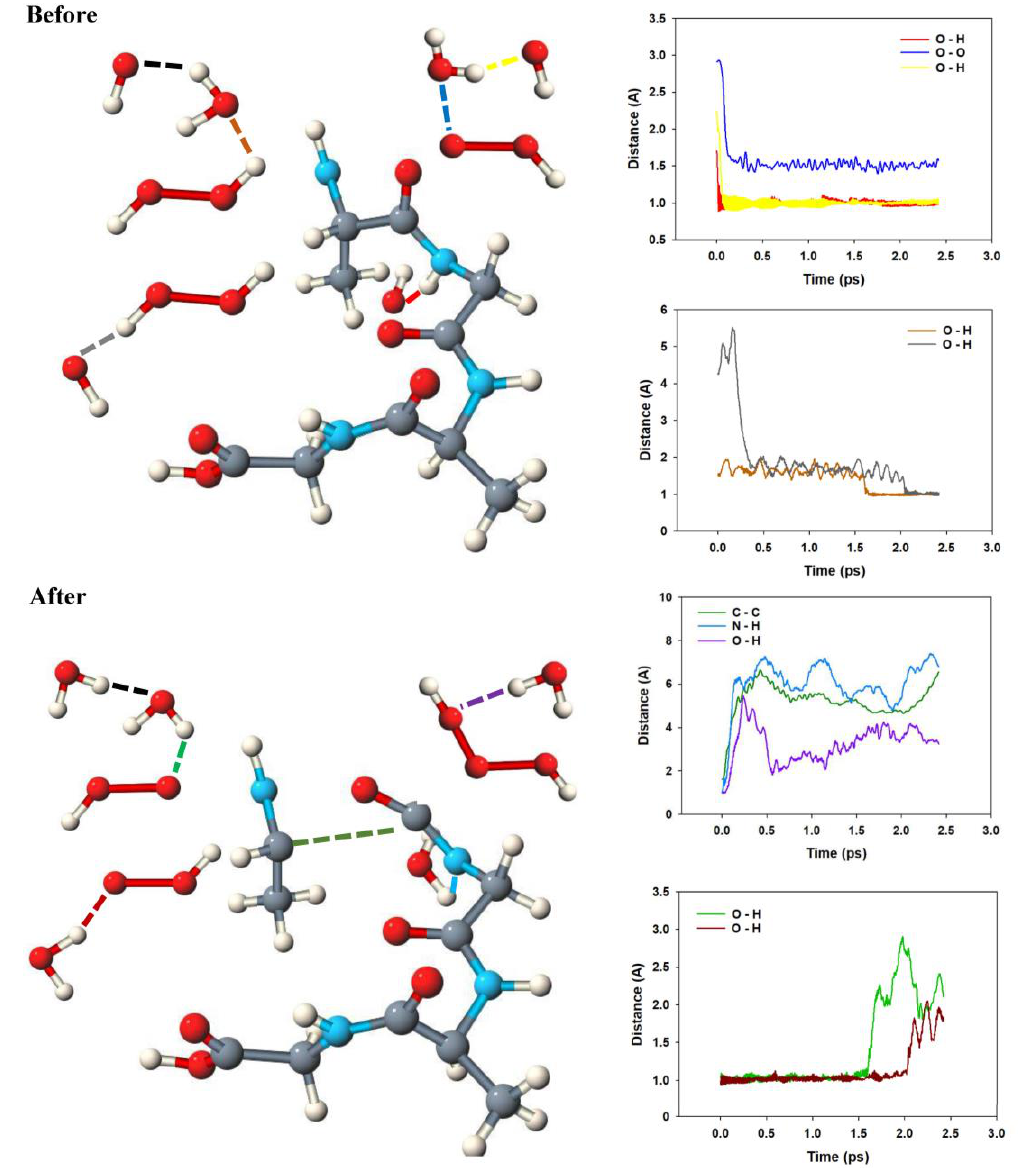
Figure 6. Sketch of the reaction of a small peptide and behavior of the most relevant bonding interactions. The breaking of the peptide chain is initiated by the attack of an OH . radical at the hydrogen atom connected to one of the nitrogen atoms of the chain (red curve). The chain breaks at the neighboring carbon atom.